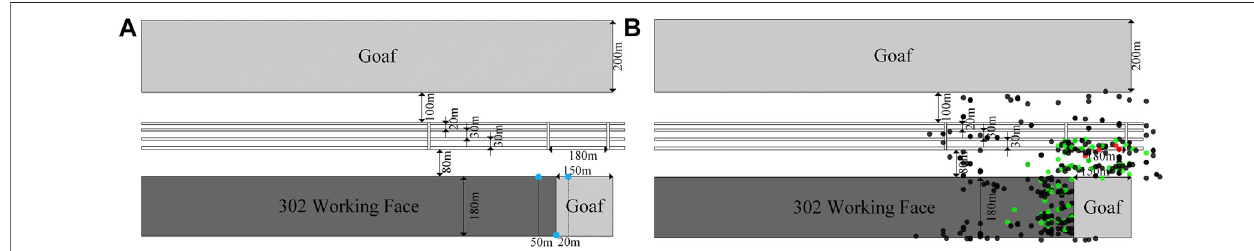
FIGURE 5 | Schematic of microseismic monitoring points and the locations of the events.